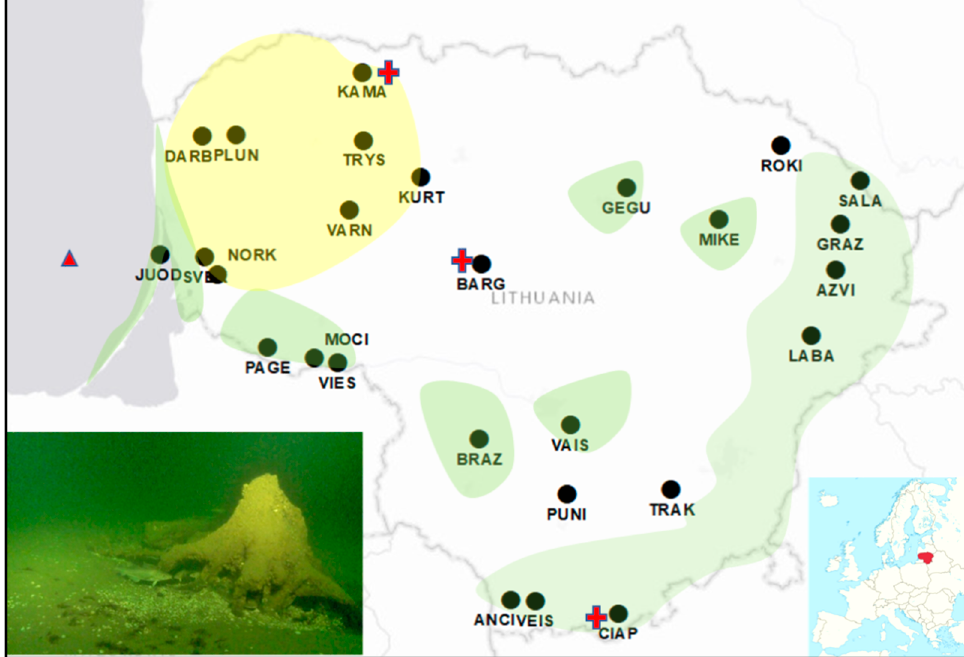
Figure 1. The location of the reference populations of Scots pine (filled circles) and the ancient underwater stumps of Scots pine found circa 12 km ashore in the Baltic sea (triangle). The three wetland Scots pine populations are marked by red crosses, located at the vicinity of the populations on normally irrigated soils of KAMA (north), BARG (near center) and CIAP populations (south). The lower right map shows the position of Lithuania in Europe. An underwater tree stump is shown in the lower left photo. The greenish darkened areas indicate the main Scots pine-dominated continuous forest tracts. These greenish areas also well coincide with the location of the poor, sandy soils. The yellowish shades outline the areas where Scots pine is common in patchy, small Norway spruce-dominated forest tracts. The deciduous forests prevail on rich, moist soils of the midland lowland.